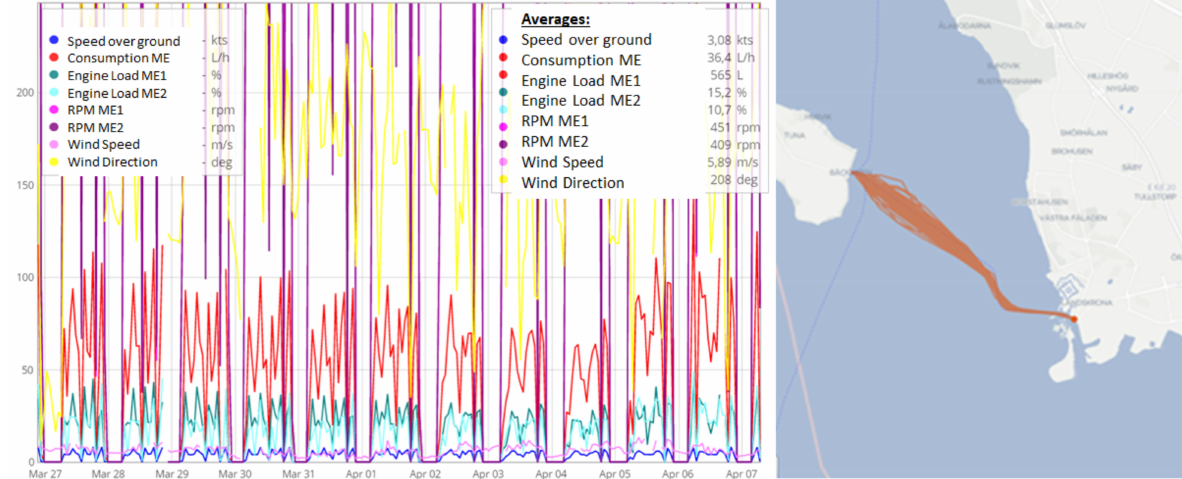
Figure 4. Screen shot of the state-of-the-art Energy Management System from Blueflow for the vessel Uraniborg sailing between Landskrona and the Island of Ven,